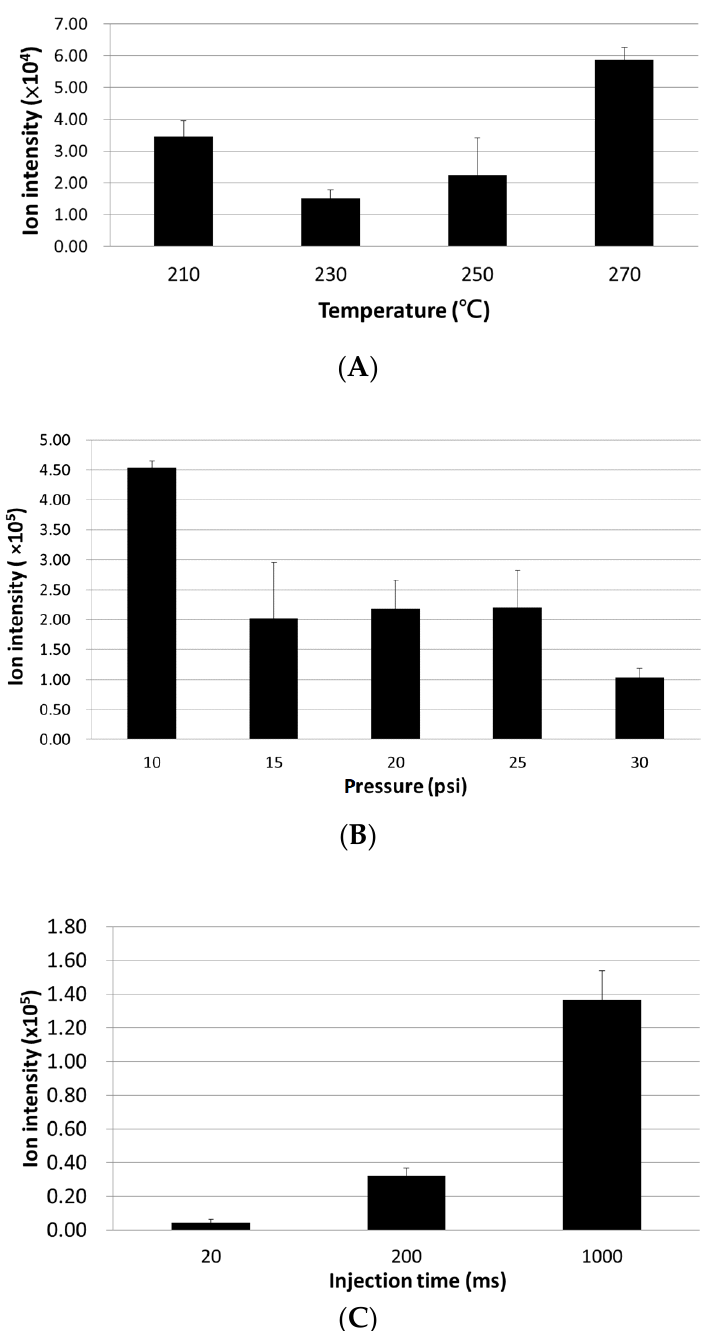
Figure 3. Effects of ( A ) capillary temperature, ( B ) sheath gas pressure and ( C ) injection time for in vitro ox-PAPC product m/z 846.5. Ox-PAPC was prepared by in vitro oxidation (FeCl 2 : H 2 O 2 = 2:1) of 100 µg/mL native PAPC standard at 37 °C for 15 min. The ion intensities were measured from the selected ion monitoring (SIM) spectra of the ion m/z 846.5.